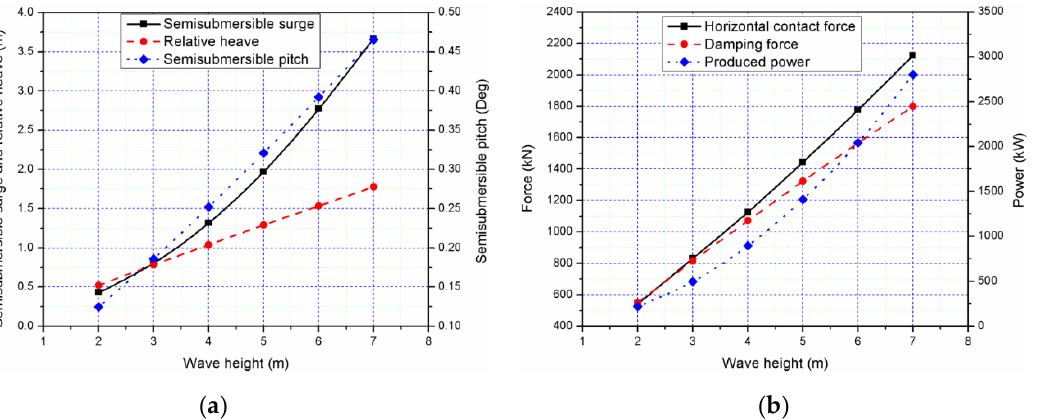
Figure 12. Responses of the combined structure under different wave heights T = 9 s: ( a ) semisubmersible surge, relative heave and semisubmersible pitch; ( b ) horizontal contact force, damping force and produced power.